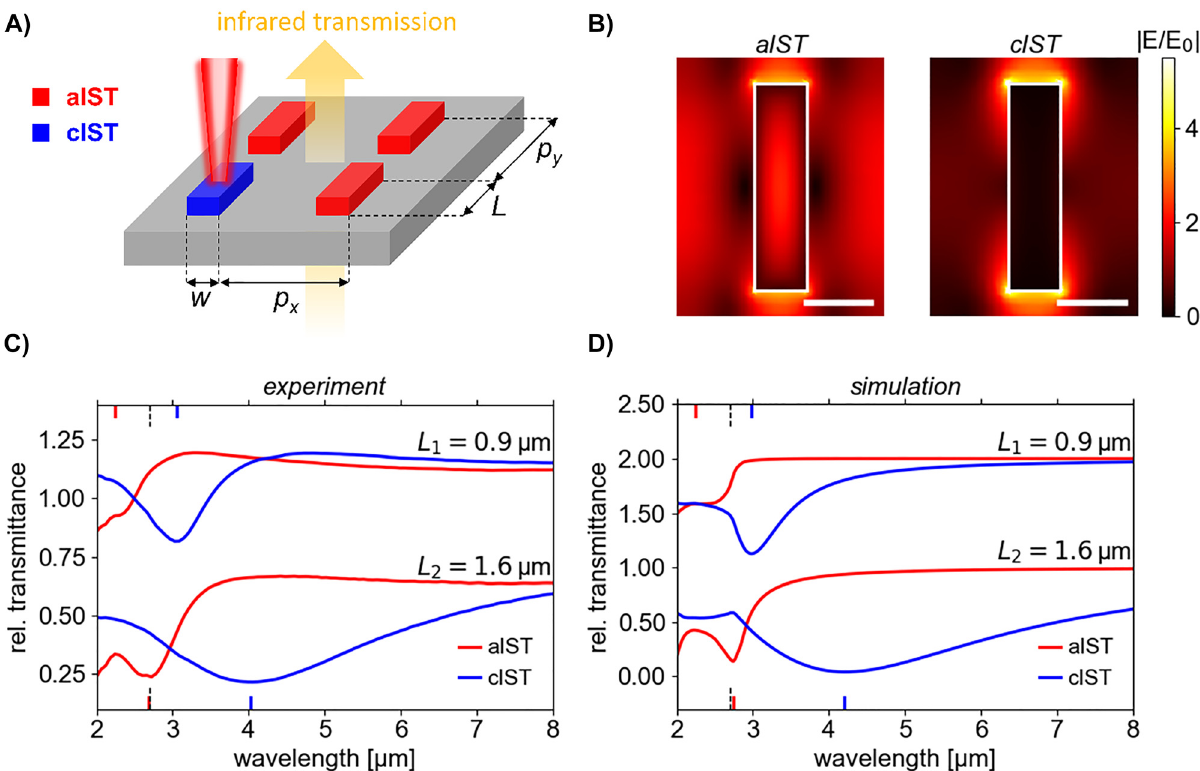
Figure 2: Resonance wavelength and width tuning with nanostructured IST rods antennas. (A) Sketch of the IST nanorod antenna array geometry, infrared illumination, and the optical crystallization of the antennas. (B) Simulated normalized absolute electric fields in the cross-section plane at half-height of the IST core of L 2 = 1.6 µm long antennas for aIST (left) and cIST (right) in resonance. The scale bar is 500nmlong.Theantennaboundaryisshownwithawhiterectangle.(C)Measuredand(D)simulatedtransmittancespectraoftworodantenna arrays with different lengths L in their aIST (red) and cIST (blue, optically crystallized) states. The dashed black line in the plots at the x -axis marks the position of the largest grating resonancethrough CaF 2 (an averageangle of incidence of 15 ° is assumed)and the colored ticksmark the transmittance minima. For clarity, the experimental spectra for L 1 are shifted by 0.5 on the y -axis and the simulated spectra by